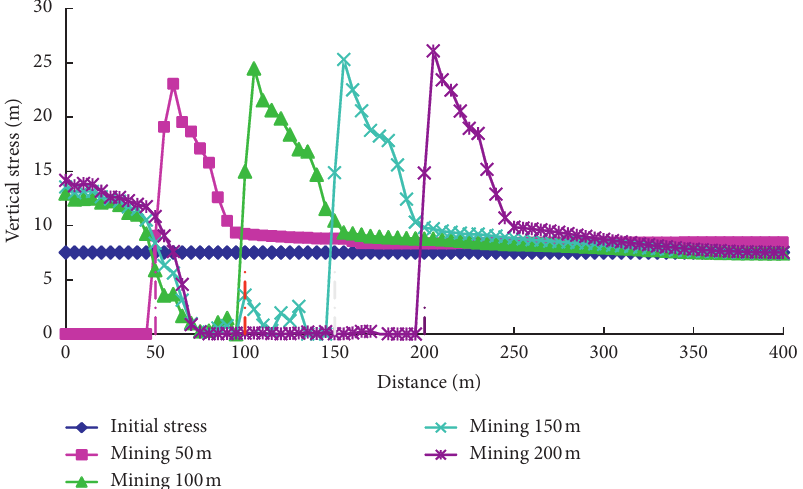
Figure 21: Vertical stress distribution of strike after mining in +550 horizontal working